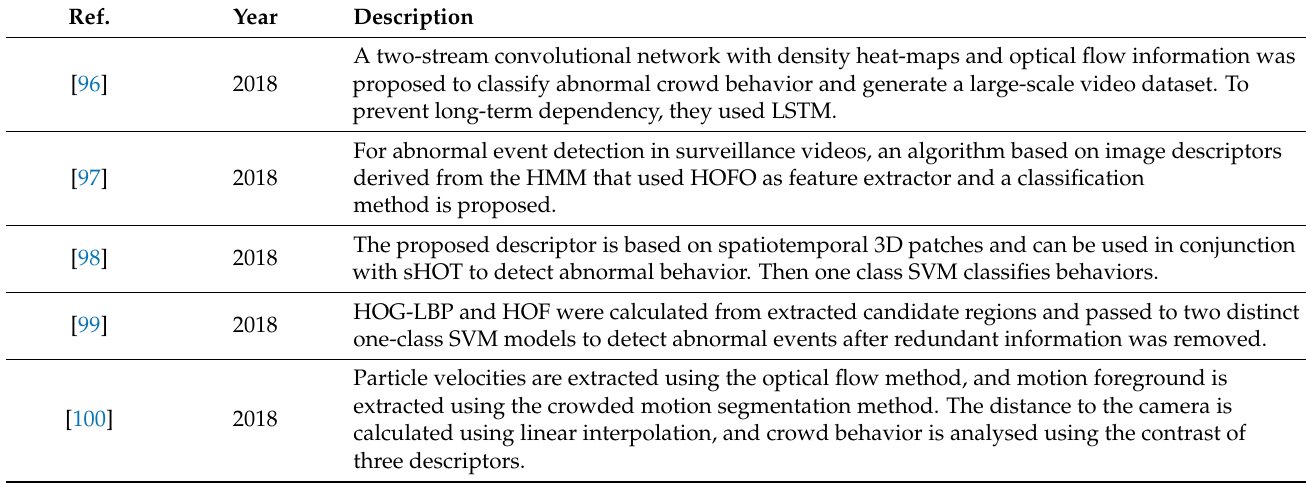
Table 7. Summary of literature on group-based